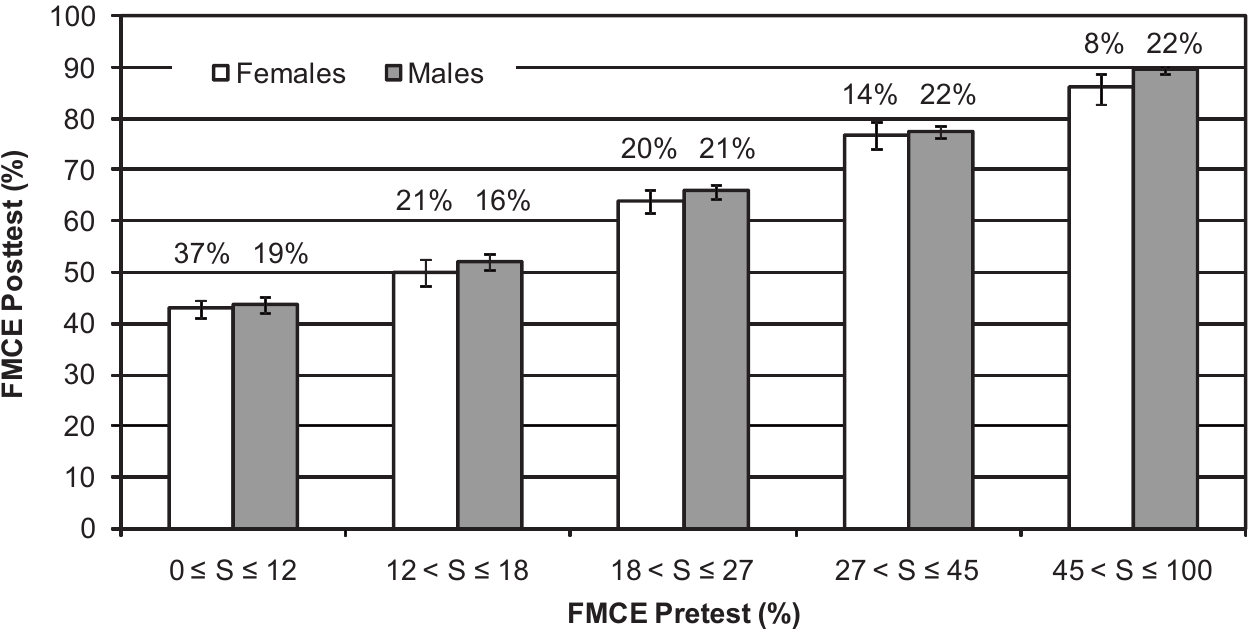
FIG. 4. Average FMCE post-test scores for females and males with matched FMCE pretest scores. The percentages above each bar represent the percentage of the females (cid:1) or males (cid:2) from the total in each bin. The error bars represent the standard error on the mean. There are no significant differences between males and females in any individual bin.